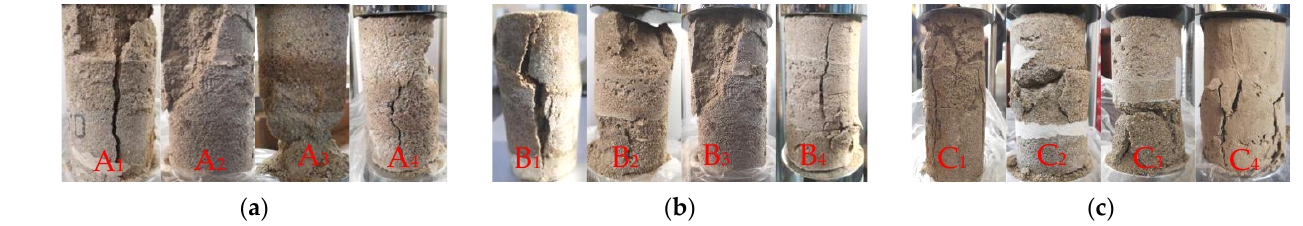
Figure 7. Failure modes under different AT, SC, and CC conditions. ( a ) Group A. ( b ) Group B. ( c ) Group C.